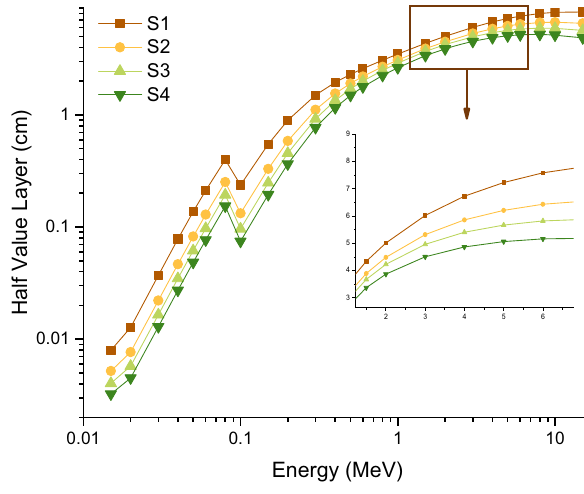
Figure 7: Variation of mass attenuation coe ffi cients ( cm 2 /g ) with photon energy ( MeV ) for all S1 – S4 glasses.